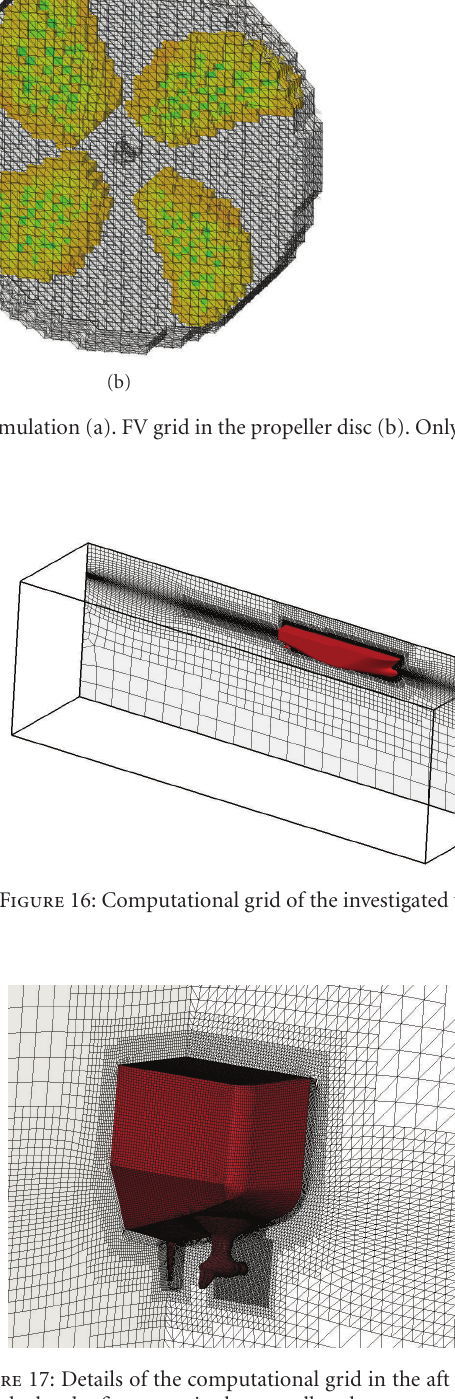
Figure 15: Geometry of the investigated vessel and the aft body of the ship including the pod housing.